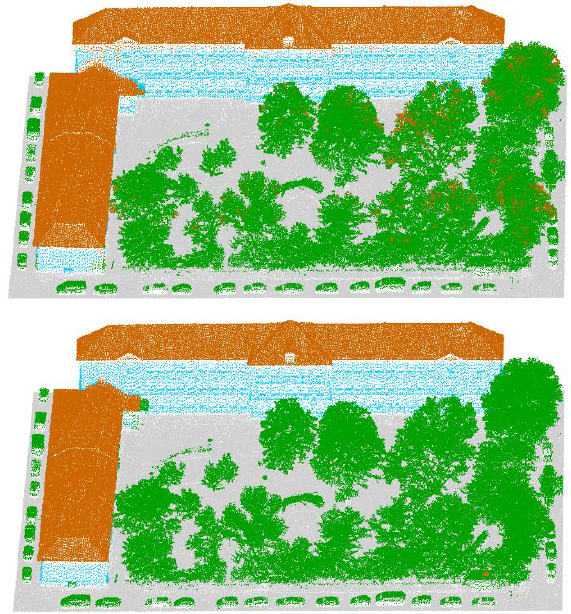
Figure 4 . Comparison of classification results between original PointNet++ (top) and PointNet++ using additional cylindrical (2D) point neighborhoods for feature extraction (bottom).